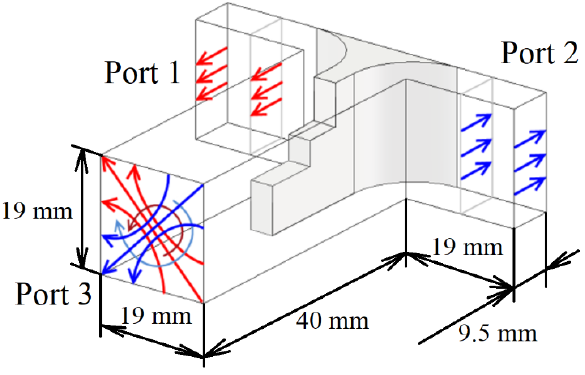
FIGURE 1. The structure of a compact 2-step septulum polarization converter and propagation of electromagnetic modes in it. Polarizer consists of an input square guide, a 2-step septulum, 2 rounded E-plane twists and two output rectangular guides. The cross-section of a square guide is